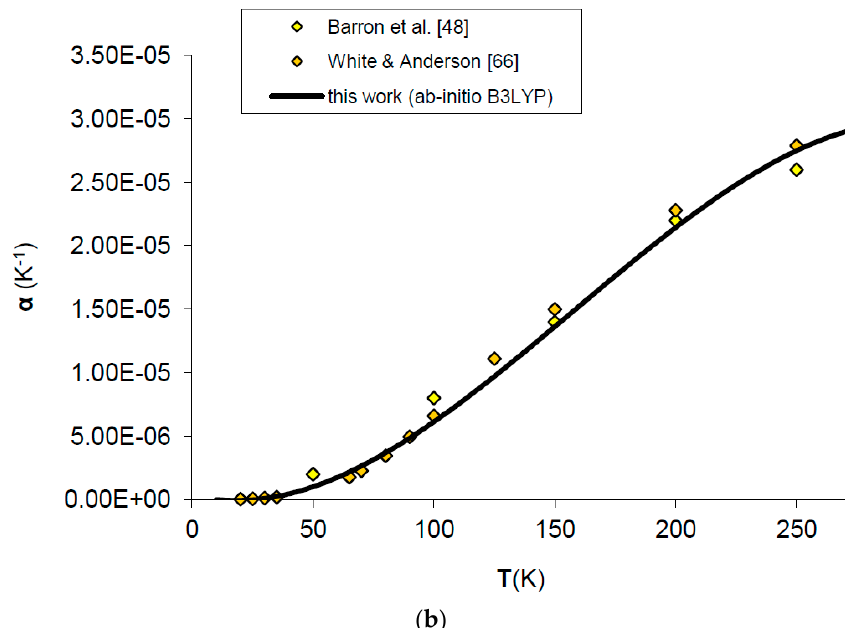
Figure 4. Ab initio B3LYP thermal expansivity ( α ) of MgO: calculated results in this work are compared to experimental data and other ab initio LDA calculations ( a ) in the whole T-range [48,49,58,65]; ( b ) in the low-T range [48,66].